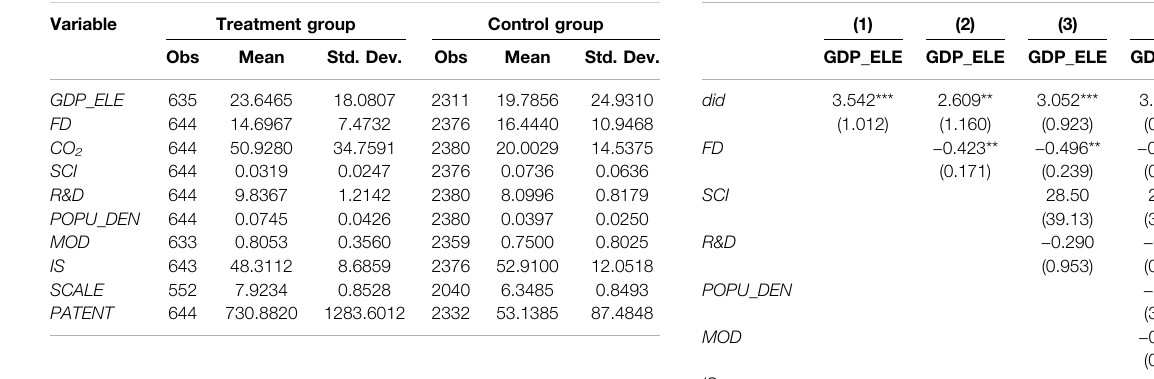
TABLE 4 | Results of the baseline